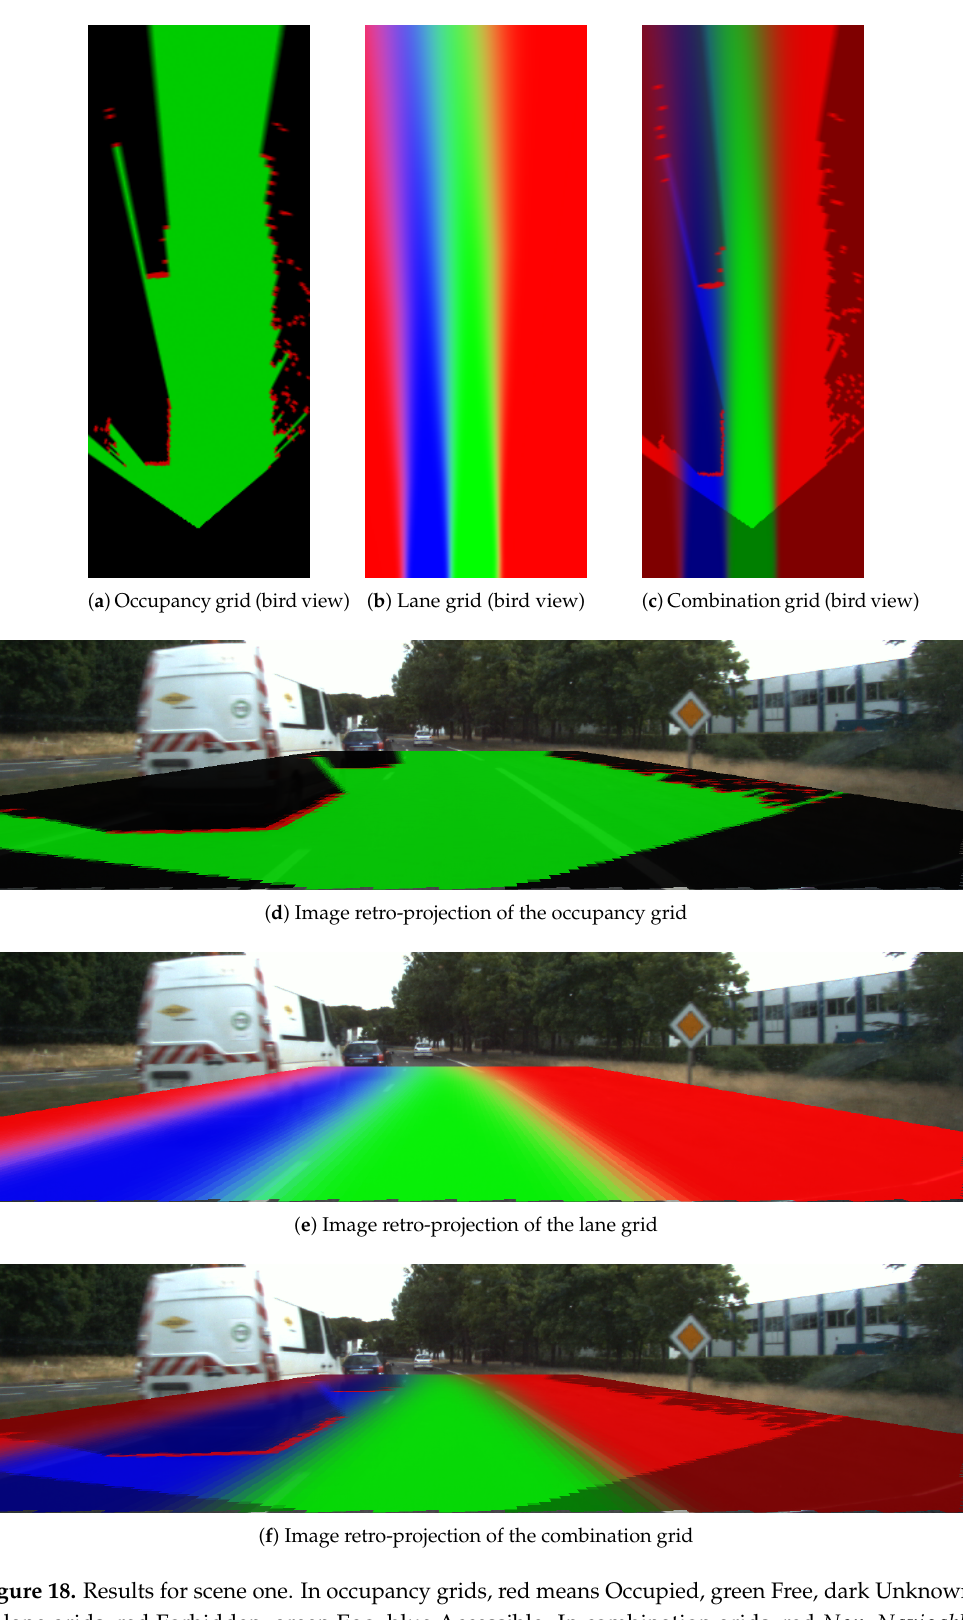
Figure 18. Results for scene one. In occupancy grids, red means Occupied, green Free, dark Unknown. In lane grids, red Forbidden, green Ego, blue Accessible. In combination grids, red Non _ Navigable plus Forbidden _ Free , green Ego _ Free , Blue Accessible _ Free